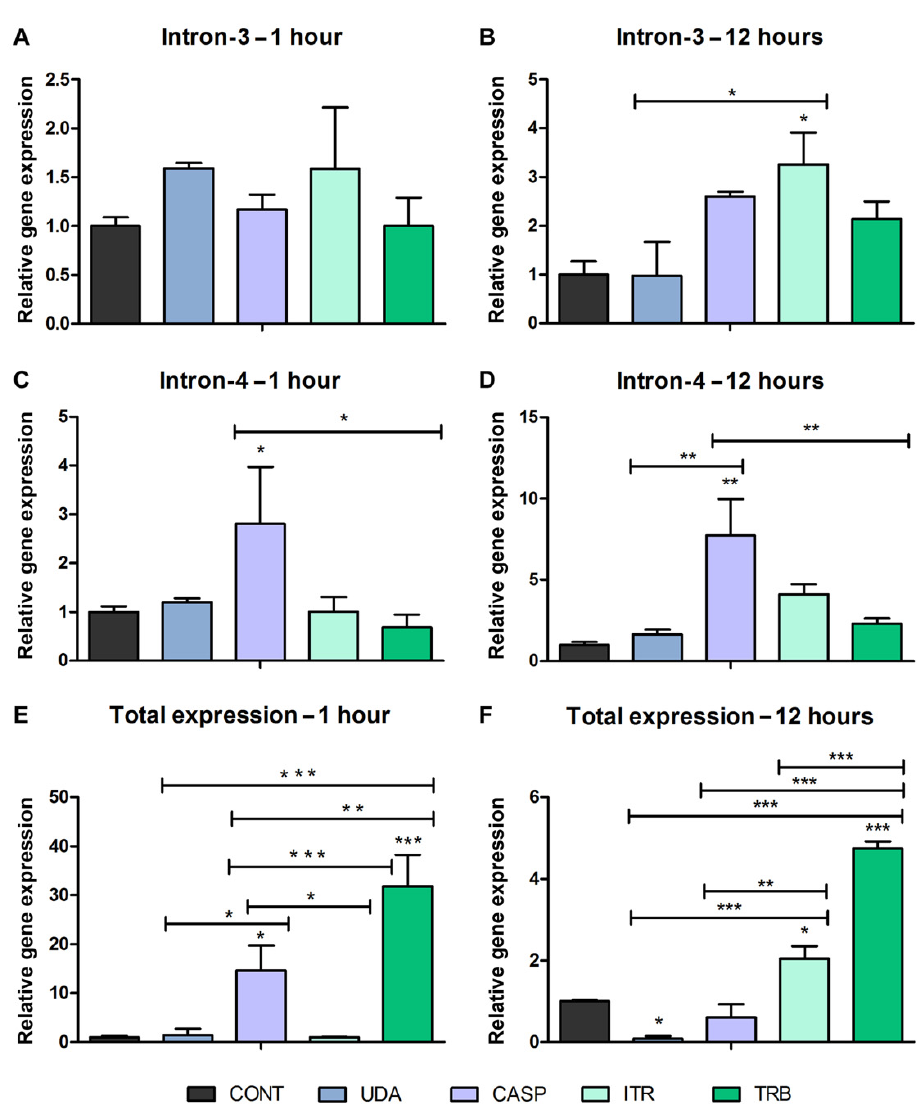
Figure 3. RT-qPCR analysis of isoform levels of the gene encoded by TERG_04309 in T. rubrum . Gene modulation data after 1 and 12 h of exposure to antifungal agents. ( A , B ) Expression levels of isoform with intron-3 retention. ( C , D ) Expression levels of the isoform with intron-4 retention. ( E , F ) Total expression levels of the TERG_04309 gene. Statistical analysis was performed using the t -test method. Asterisks refer to * p < 0.05, ** p < 0.01, and *** p < 0.001. As a reference for modulation, the condition of paired controls of 1 h and 12 h was used. Control sample (CONT); undecanoic acid (UDA); caspofungin (CASP); itraconazole (ITR), and terbinafine (TRB).